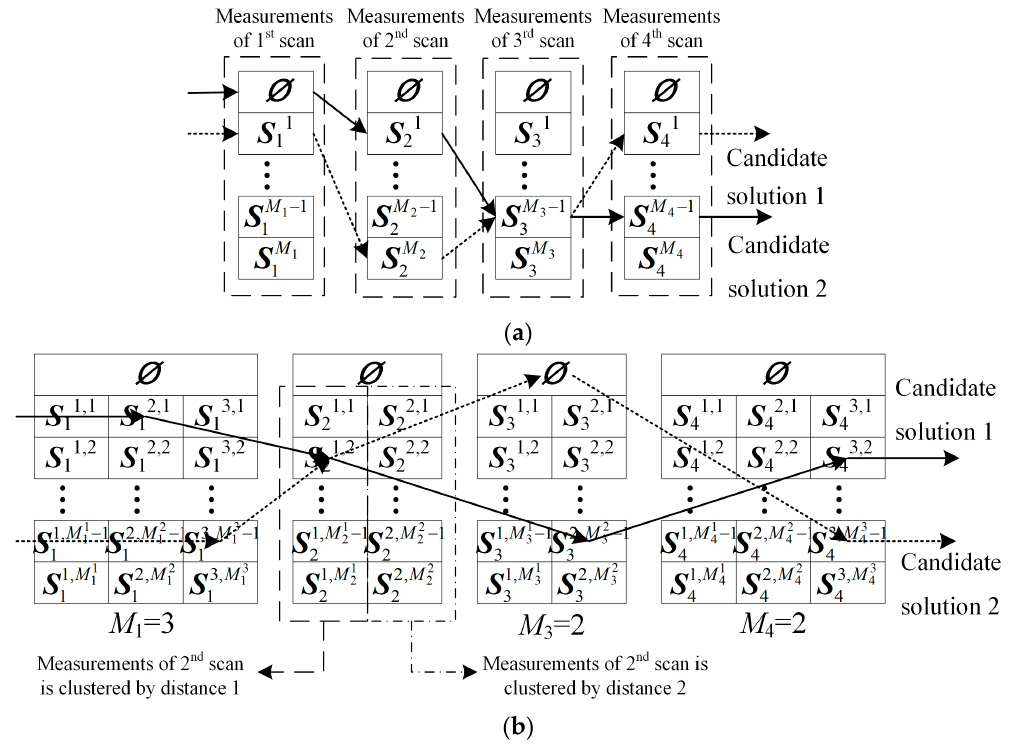
Figure 2. The schematic diagram of the candidate solution. ( a ) Candidate solution with a single distance threshold is applied to partition the measurements. ( b ) Candidate solution with alternative partitions are applied to partition the measurements.